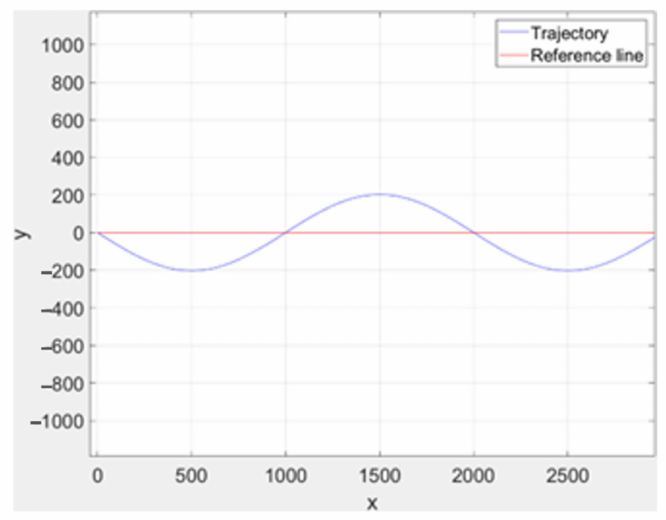
Figure 6. Simulated